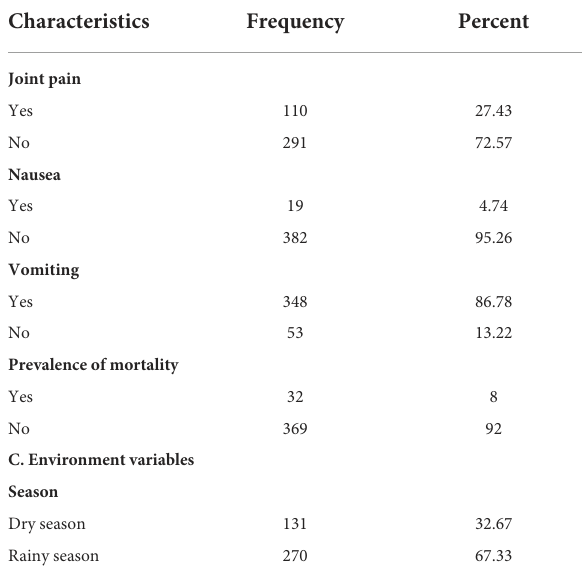
TABLE 1 Description of the patients with severe